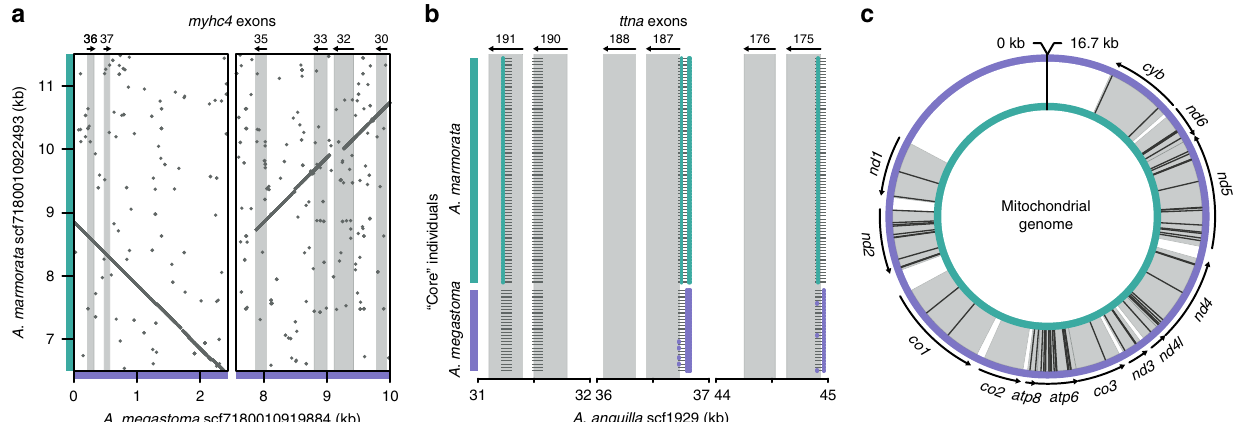
Fig. 4 Potential causes of cytonuclear incompatibility between A . marmorata and A . megastoma . a Dot plot visualizing an inversion between A . megastoma scaffold scf7180010919884 (purple) and the homologous A . marmorata scaffold scf7180010922493 (cyan). Each dot represents a tuple of nine nucleotides that are identical or the reverse complement between the two scaffolds. Light gray rectangles mark regions homologous to exons of the zebra fi sh ( Danio rerio ) myhc4 gene; order and orientation of these exons are indicated at the top (Supplementary Table 12). The inversion may thus affect the transcript of this gene in A . megastoma . Other detected genomic rearrangements are shown in Supplementary Figs. 21 and 22. b Illustration of fi xed sites in coding sequences between A . marmorata and A . megastoma . Light gray rectangles mark regions homologous to exons of the zebra fi sh ttna gene (Supplementary Table 14). Dark gray lines indicate RAD sequences for 72 and 26 “ core ” individuals of A . marmorata and A . megastoma , respectively. Nonreference genotypes are colored according to the species in which the genotype is most frequently found. Within exon 191, an adenine to guanosine substitution in A . marmorata at position 32,226 of A . anguilla scaffold scf1929 changes amino acid 5732 of the protein from aspartic acid to glycine. Other protein-coding sites fi xed between A . marmorata and A . megastoma are listed in Supplementary Table 13. c Nonsynonymous substitutions between the A . marmorata (inner, cyan circle) and A . megastoma (outer, purple circle) mitochondrial genomes. Gray segments indicate protein-coding genes and nonsynonymous substitutions within these are shown with black lines. All mitochondrial amino-acid changes are listed in Supplementary Table